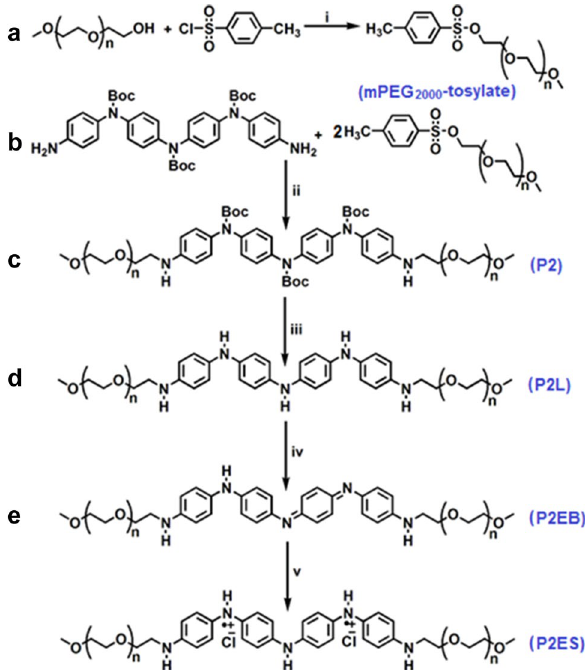
Figure 1. Synthesis of amphiphilic ABA type triblock copolymers containing secondary amine (NH) linkage ( a–e ). (i) NaOH, THF, 0–5 °C, 4 h; (ii) DMAP, ET 3 N, DMSO, 65 °C, 24 h; (iii) TFA, DCM, 0 °C to room